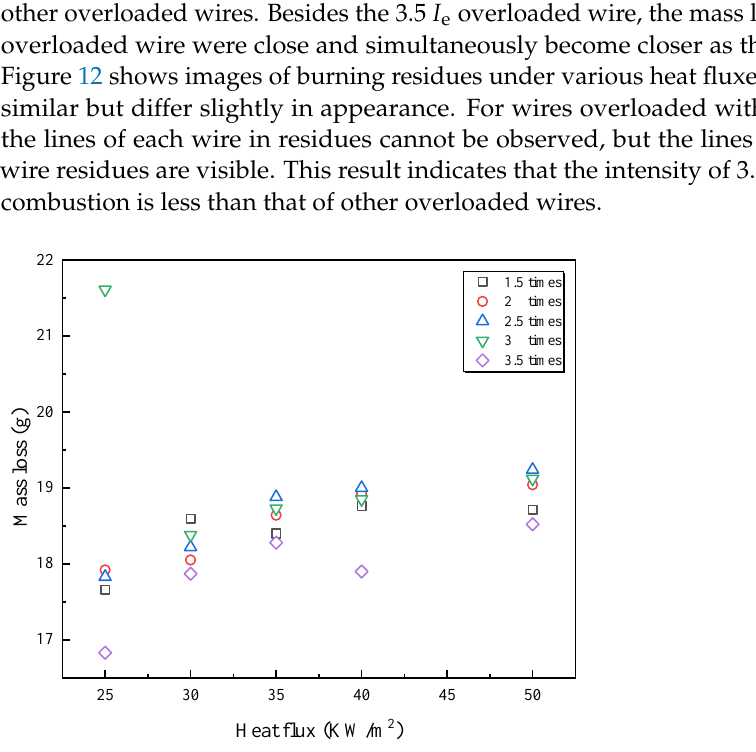
Figure 11. Mass loss under various heat flux and overload current